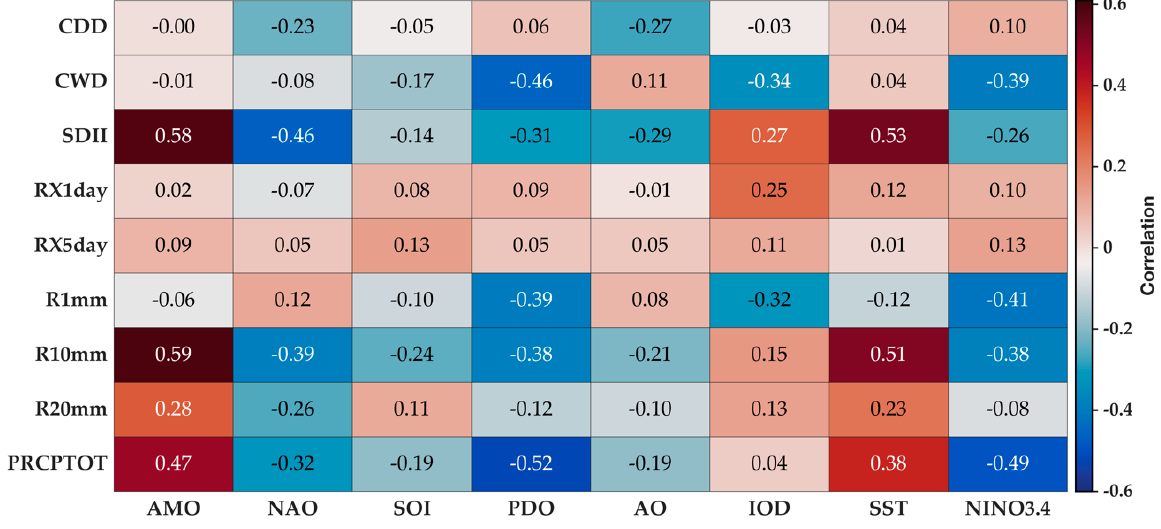
Figure 6. Correlation between precipitation extremes and ocean-atmospheric circulation patterns on the annual scale over GRB from 1985 to 2014.